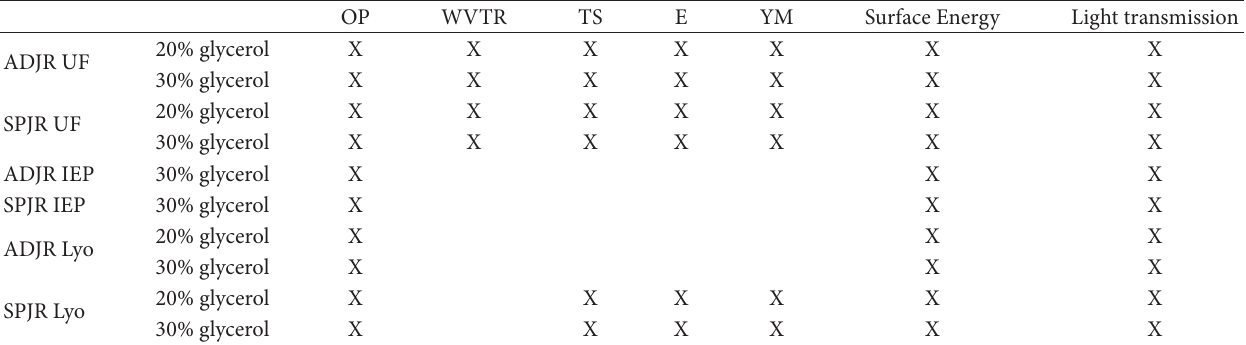
Table 2: Measurements performed to the cast films obtained from the different Jatropha protein products (see Table 1). OP WVTR TS E YM Surface Energy Light transmission ADJR